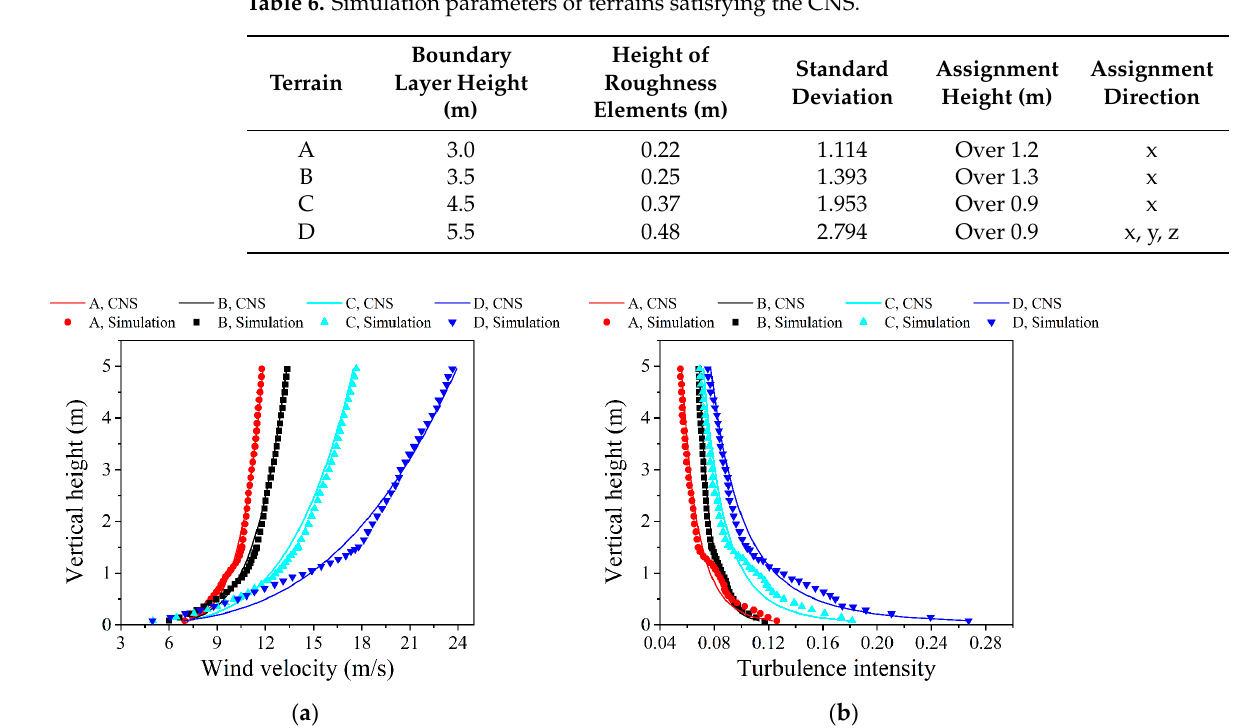
Figure 9. Comparisons of the simulation results for standard terrains and Chinese national standards: ( a ) Wind velocity profile; ( b ) Turbulence intensity profile.